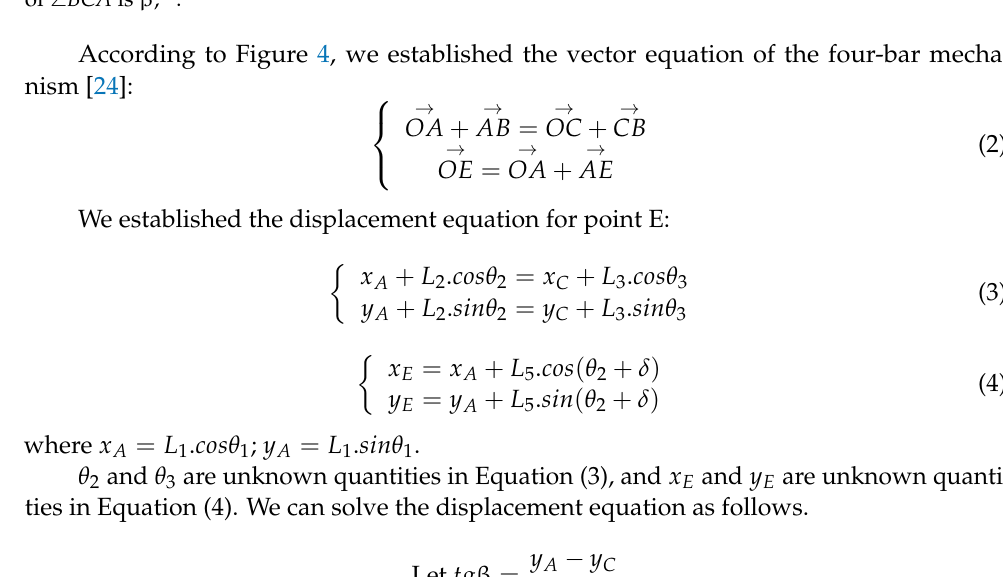
Figure 4. Analysis of the four-bar mechanism. V T is the forward speed of the transplanter during field work; OA is the crank; O is the crank rotation center; BAE is the link; AE is the gripping lever; BC is the rocker; OC is the frame; the length of OA is L 1 , mm; the length of AB is L 2 , mm; the length of BC is L 3 , mm; the length of OC is L 4 , mm; the length of AE is L 5 , mm; the angle formed by OA and OC is denoted by θ 1 , ◦ ; the angle formed by AB and the horizontal plane is denoted by θ 2 , ◦ ; the angle formed by BC and the horizontal plane is denoted by θ 3 , ◦ ; the angle of ∠ BAE is δ , ◦ ; the angle of ∠ BCA is β , ◦